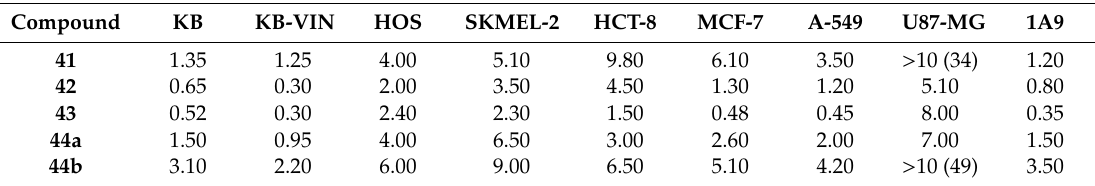
Table 14. Cytotoxic activities (ED 50 values µg/mL) of compounds 41 – 44b against the epidermoid carcinoma of the nasopharynx KB, P-gp-expressing epidermoid carcinoma of the masopharynx KB-VIN, osteosarcoma Hos, melanoma SKMEL-2, ileocecal carcinoma HCT-8, breast cancer MCF-7, lung carcinoma A-549, glioblastoma U87-MG, and ovarian cancer 1A9 cell